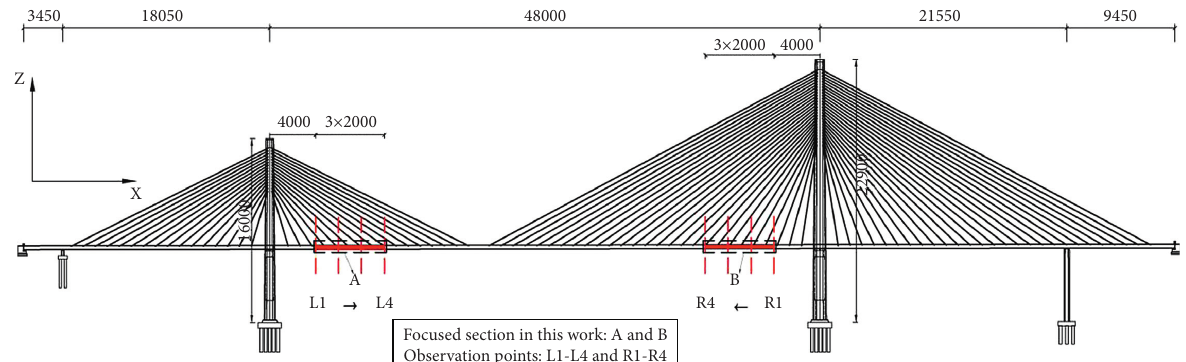
Figure 3: Bridge structural layout (unit: cm).